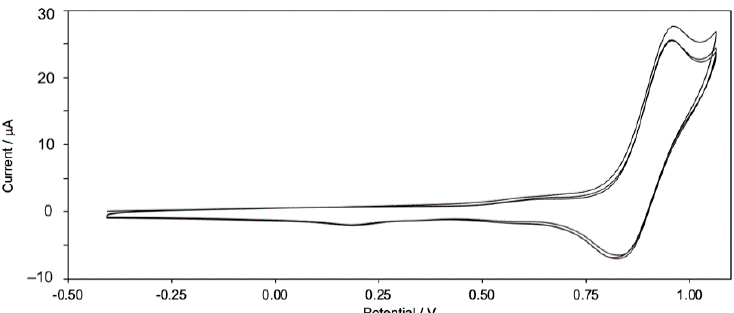
Figure 5. Three consecutive scans in the oxidative part of the cyclic voltammogram of [Cu(xantphos)(6-Cl-6’-Mebpy)][PF 6 ] in CH 2 Cl 2 solution (ca. 10 − 4 mol dm − 3 ). [ n Bu 4 N][PF 6 ] was used as the supporting electrolyte (scan rate = 0.1 V s − 1 , reference Fc/Fc + = 0.0 V).